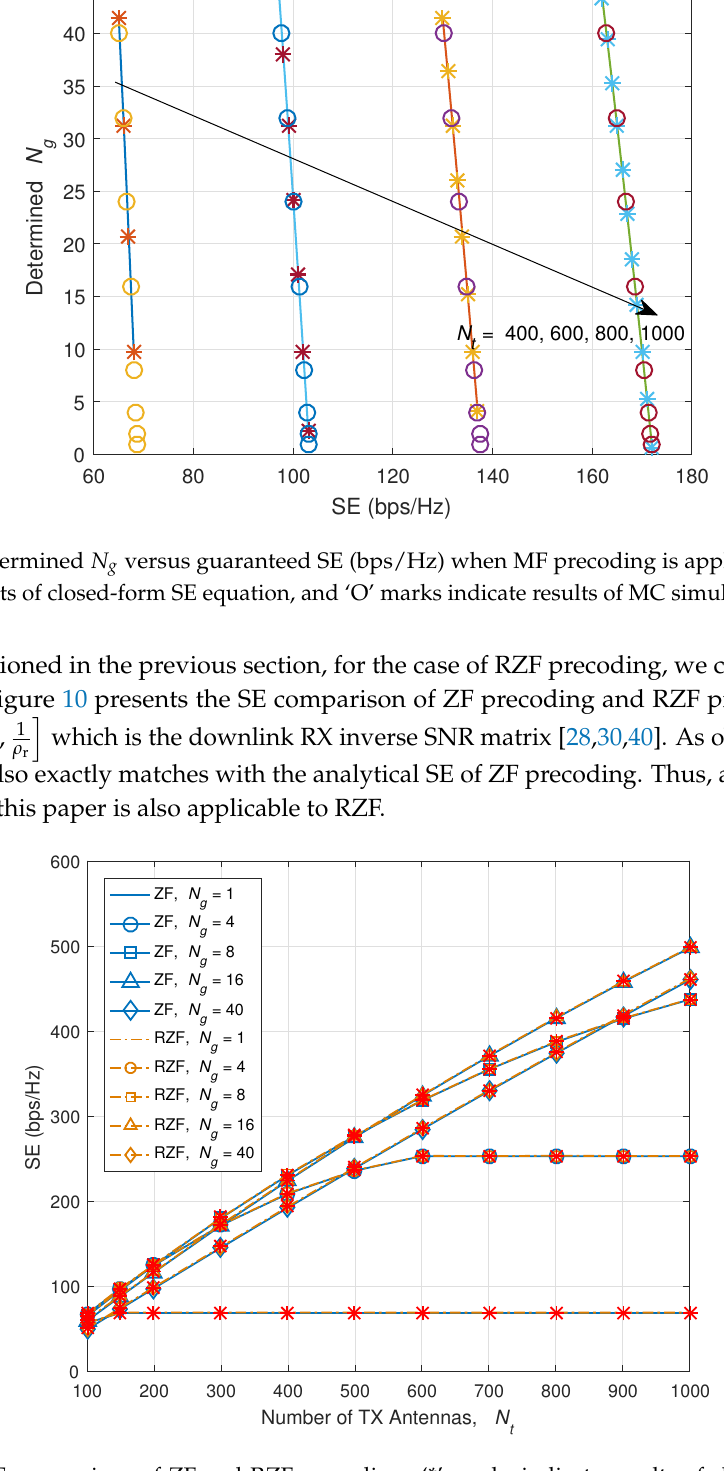
Figure 10. SE comparison of ZF and RZF precoding. ‘*’ marks indicate results of closed-form SE equation for ZF